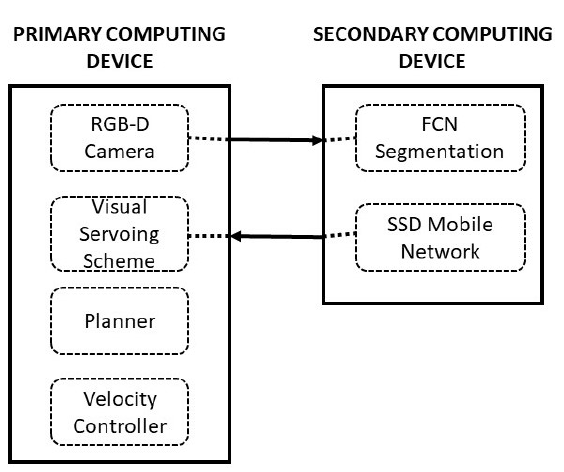
Figure 9. HSR computing